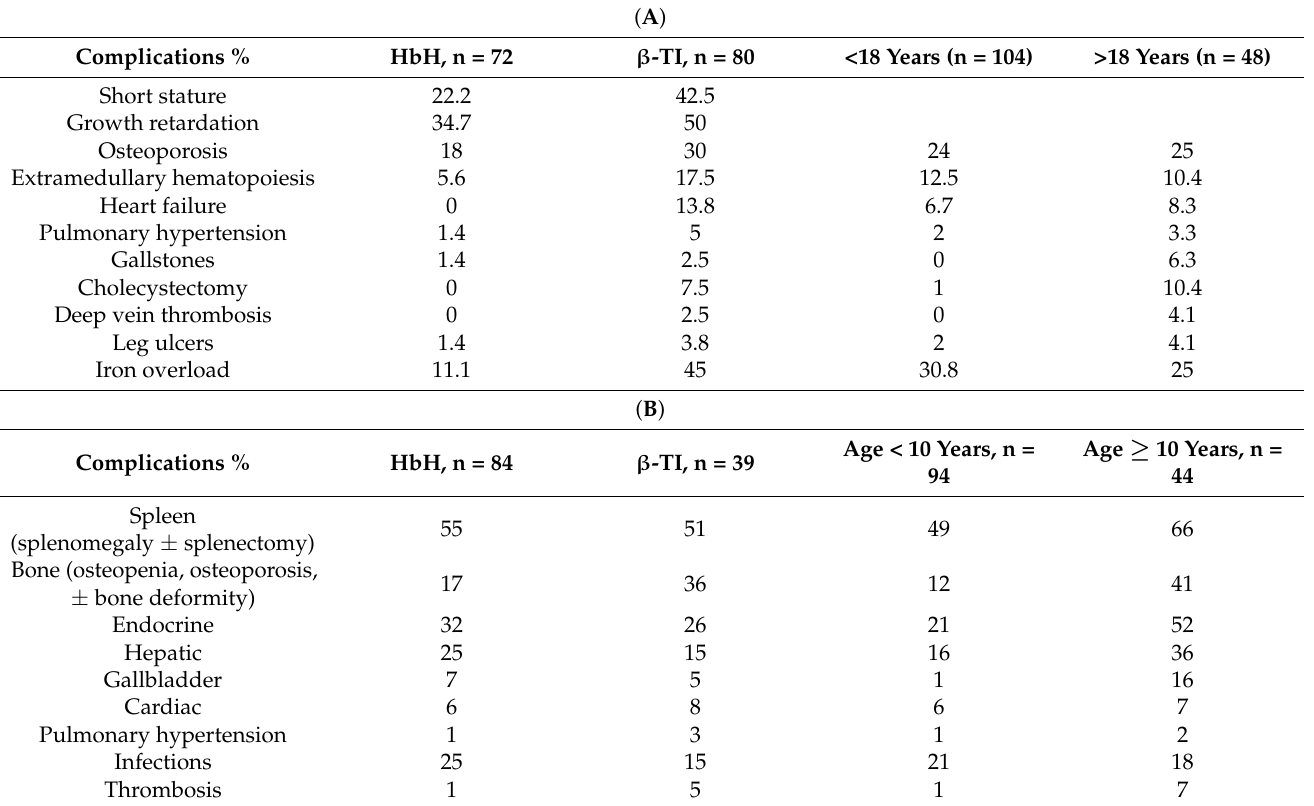
Table 3. ( A ) Differences between HbH and β -thalassemia [46]. ( B ) Differences between HbH and β -thalassemia